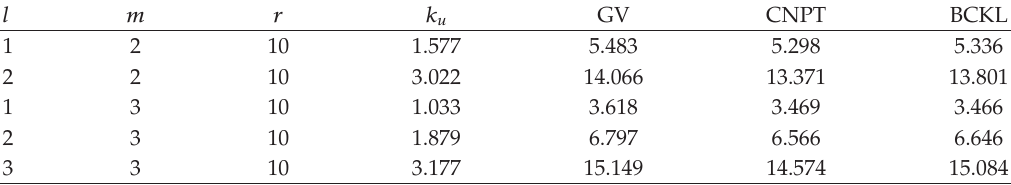
∗ Results are obtained assuming unknown scale and shape parameters a, b Table 4: 95% Upper prediction limits for the vinyl chloride